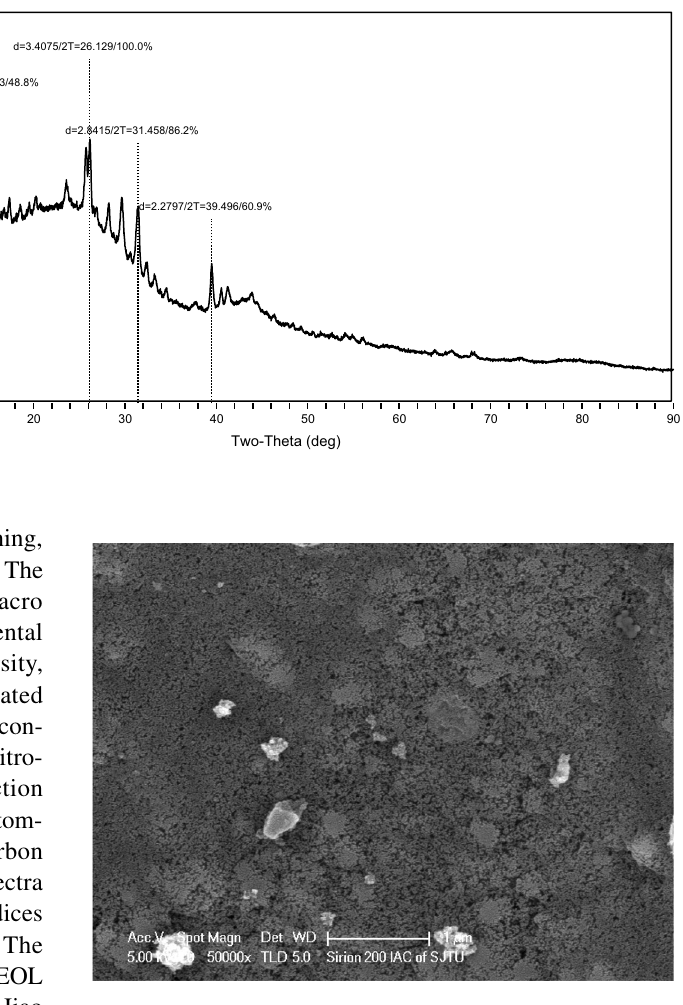
d=6.3370/2T=13.963/48.8%d=3.4075/2T=26.129/100.0%